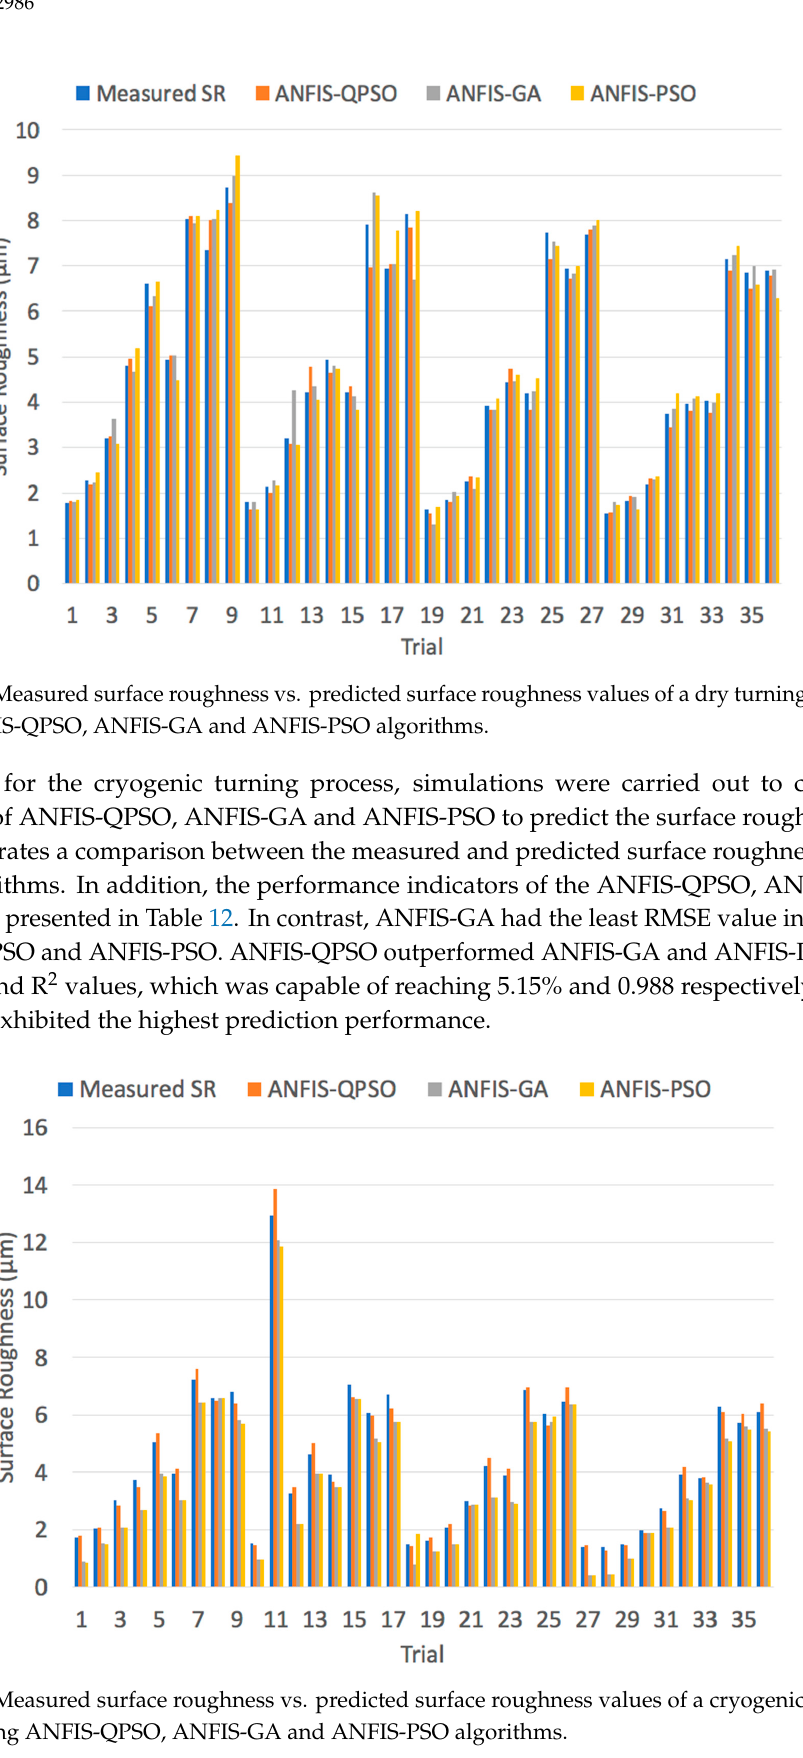
The superior performance of ANFIS-QPSO can be interpreted by its capability in converging to